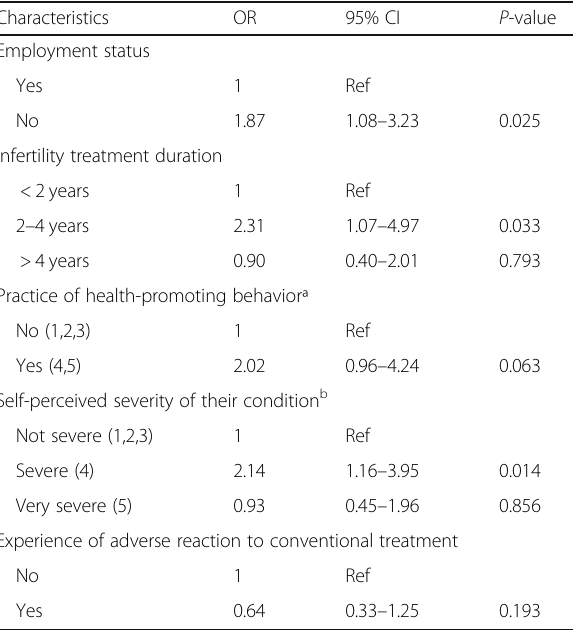
Table 5 Clinical characteristics of respondents by perceived severity of disease ( n = 263) Characteristics